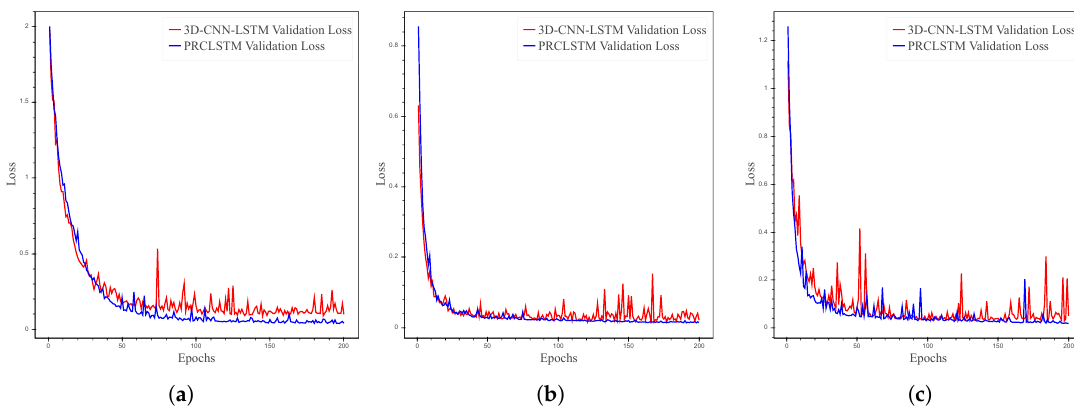
Figure 7. The validation loss during the training of the 3-D convolutional neural network (CNN)-LSTM and PRCLSTM for ( a ) Indiana, ( b ) PaviaU, and ( c ) Salinas. Table 5. A comparison between the classification results of the Indiana dataset with a fixed spatial size of the input cube and a sufficient number of training